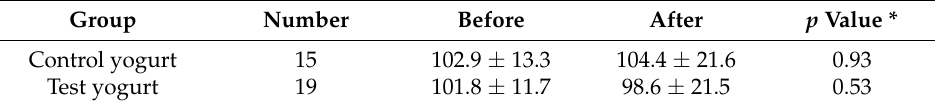
Table 4. Effect of yogurt on the LDL values of the LDL normal (<120 mg/dL) volunteers. Group